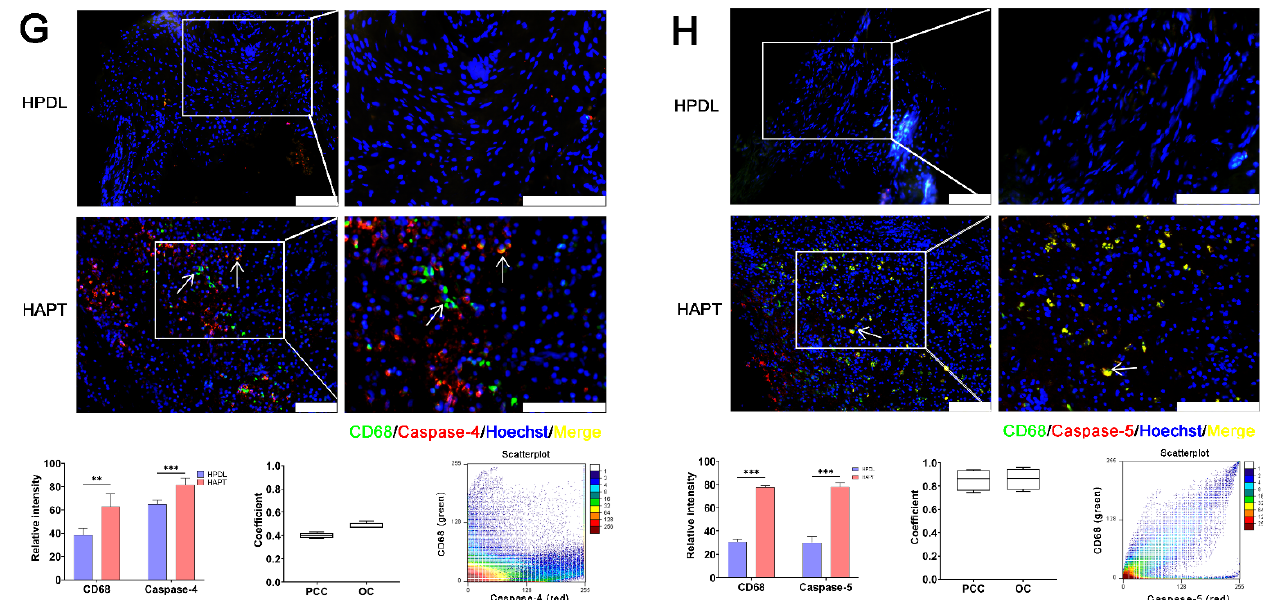
Figure 2. Caspase-1/-4/-5 mediate different levels of pyroptosis in human AP. ( A ) Triple labelling of caspase-5 (green), caspase-4 (red) and Hoechst (blue) was performed by using immunofluorescence. Caspase-4 and caspase-5 partially overlapped. ( B , C ) Triple labelling of caspase-1 (green), caspase-4/-5 (red) and Hoechst (blue) was performed by using immunofluorescence. Caspase-1 and caspase-4 did not overlap, but caspase-1 and caspase-5 overlapped. ( D , E ) TUNEL (green), caspase-4/-5 (red) and Hoechst (blue) staining were performed using TUNEL staining and immunofluorescence. Most of the caspase-4/-5 + cells underwent pyroptotic cell death (Bar, 100 μm). ( F ) Triple labelling of caspase-1 (green), CD68 (red) and Hoechst (blue) was performed by immunofluorescence. The results showed that most CD68 + macrophages expressed caspase-1 (Bar, 100 μm). ( G,H ) Triple labelling of CD68 (green), caspase-4/-5 (red) and Hoechst (blue) was performed by immunofluorescence. The results indicated that caspase-4 was not activated but caspase-5 was activated in CD68 + macrophages (Bar, 100 μm). *, p < 0.05; **, p < 0.01; ***, p < 0.001.